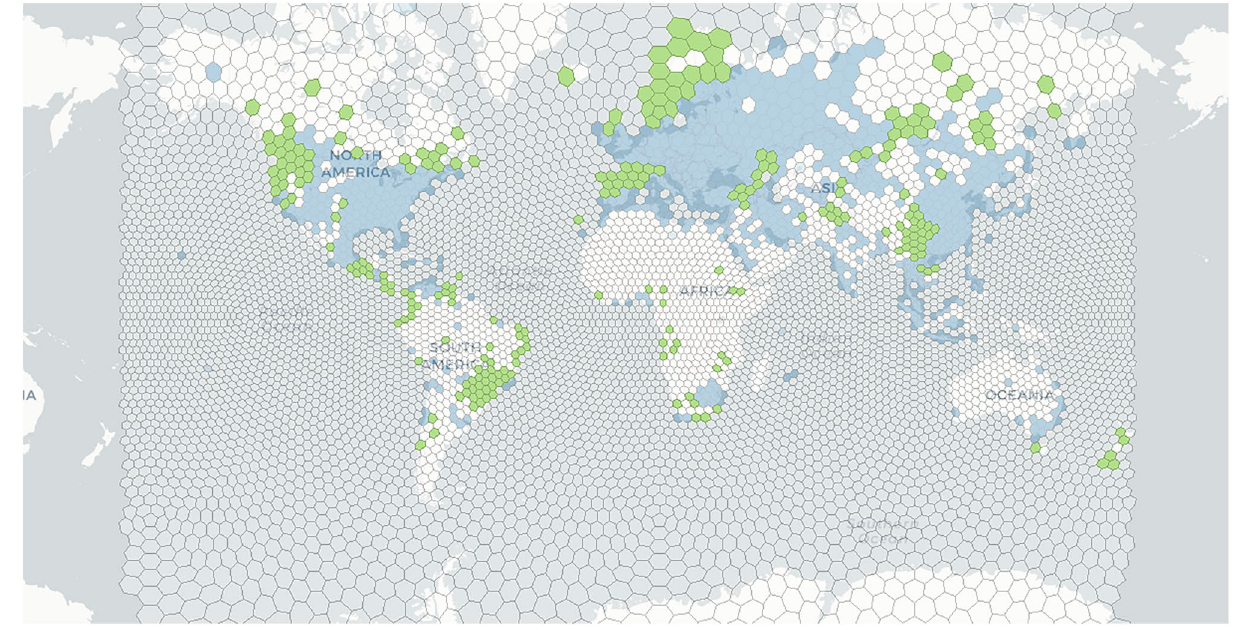
Figure 5. ‘Spatial hit’ index indicates the potential locations suitable for renewable mining. Grids with ‘spatial hit’ index = 2 (i.e. suitable for renewable mining) are highlighted in green (n = 247). Details of the definition and calculation of the index are provided in “Methods”. The results associated with this map are shown in Supplementary Table S4. The results are based on the monthly data from June 2018 to May 2019. The map is created by Geoda 1.18 (http:// geoda center. github. io/ downl oad.